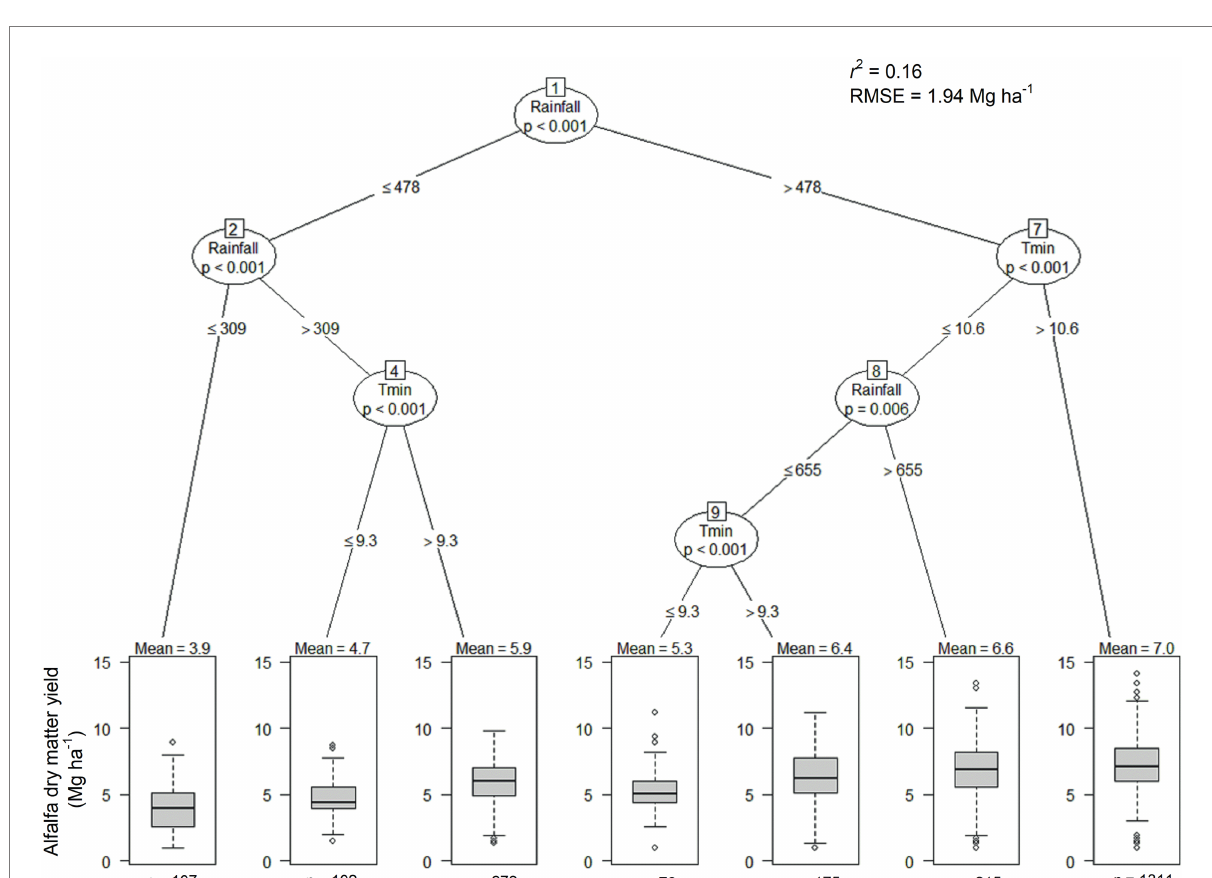
FIGURE 5 Conditional inference tree for alfalfa forage yield as function of the interaction between growing season weather variables (cumulative rainfall and growing degree days, and mean Tmax and Tmin) for 393 counties over 10 years period. The oval-shaped circle contains a specific predictor that affects yield, the branches represent binary partition of the variables based on the shown threshold of predictor. Each boxplot inside the terminal nodes represents the interquartile range (gray box), median (solid line inside the gray box), upper and lower extreme (whiskers), and outliers (black circles) of alfalfa yield in Mg ha − 1 . The value of n on the bottom of the terminal node represents the total number of observations in each terminal node. The GSR is expressed in mm and Tmin in o